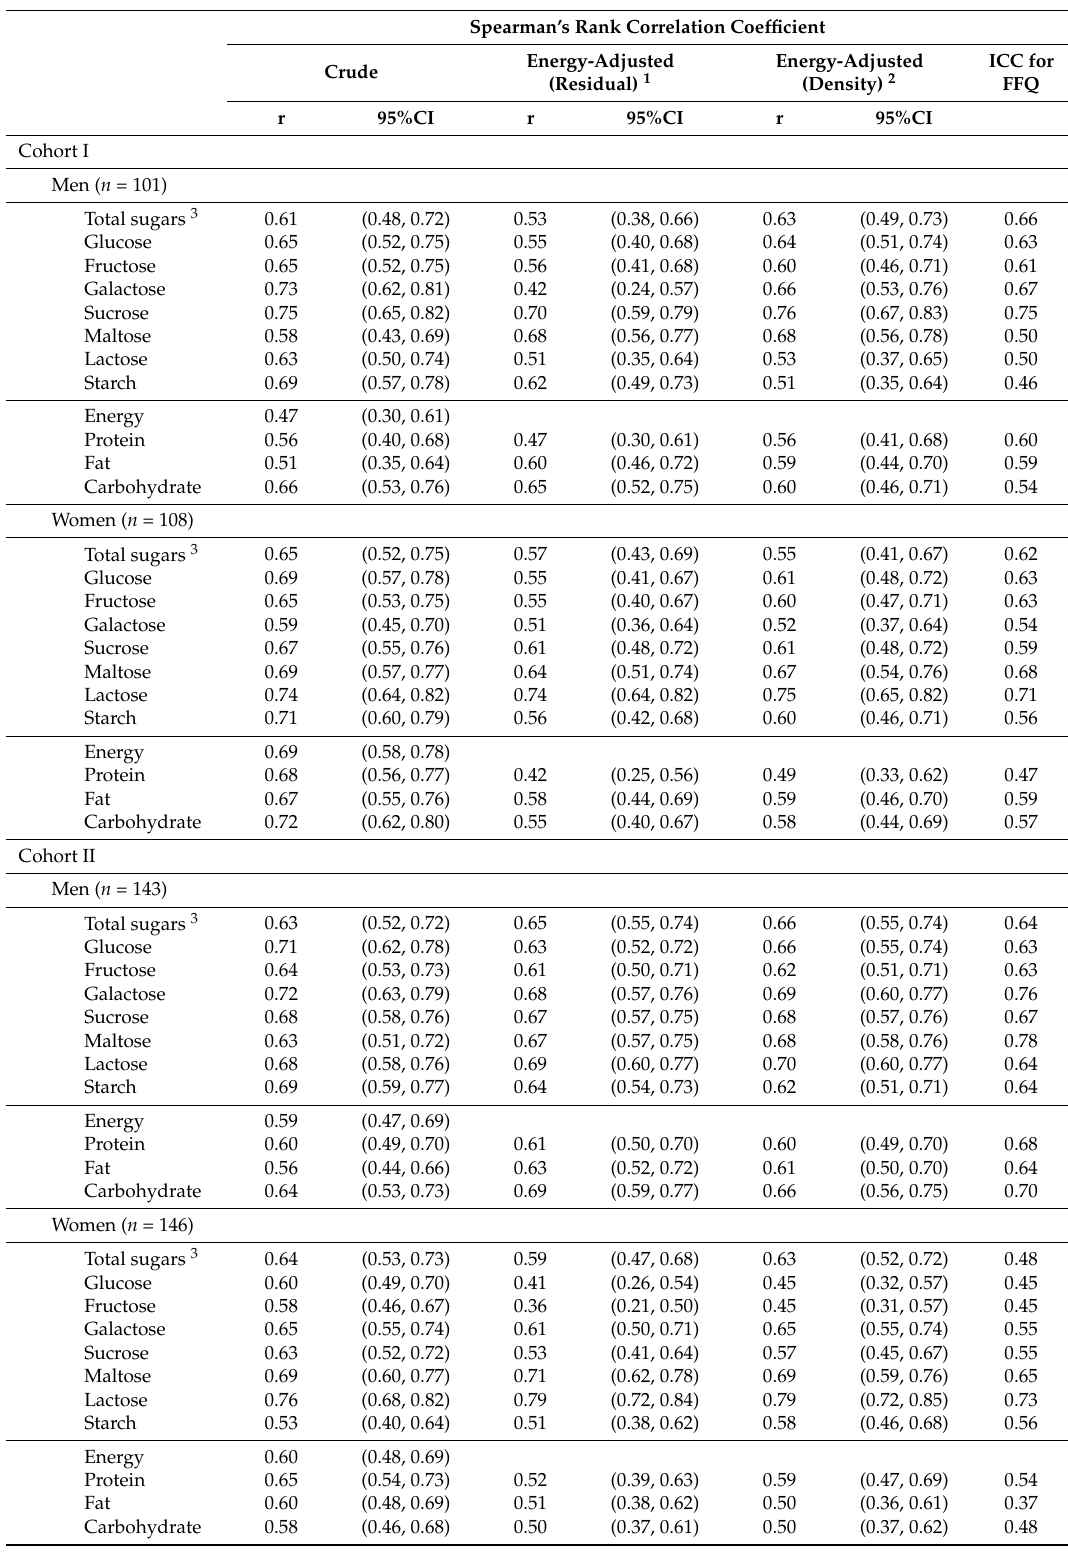
Table 6. Correlations between FFQv and FFQr